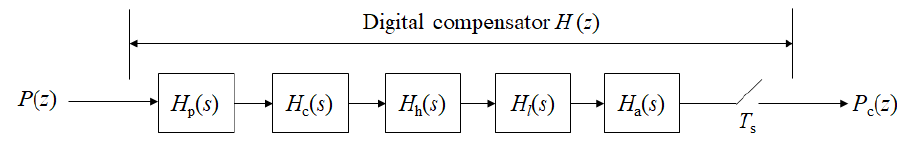
Figure 3. Structure of the digital compensator.